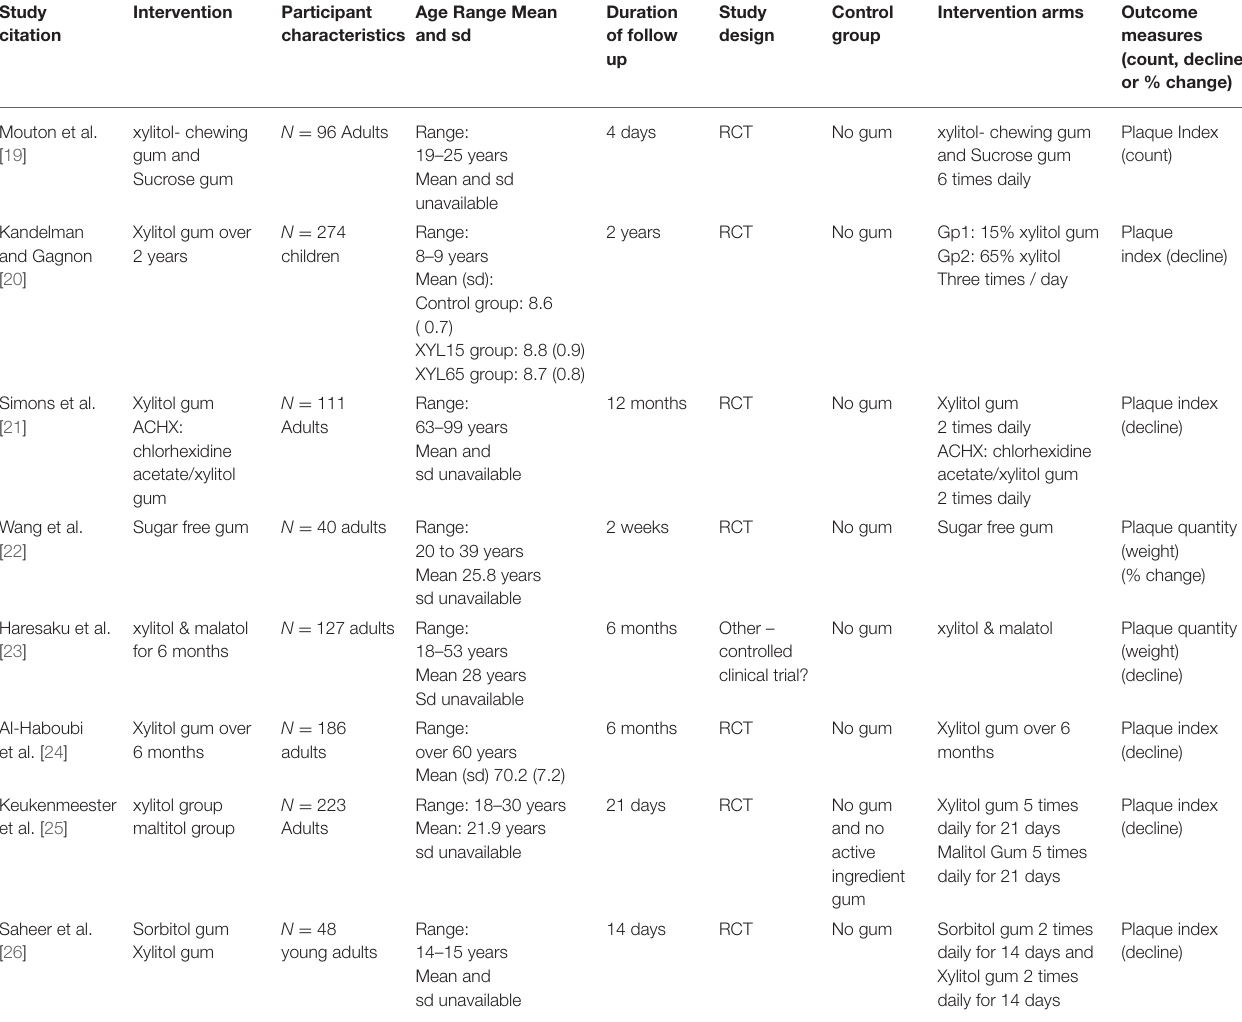
TABLE 2 | Summary characteristics of included studies.